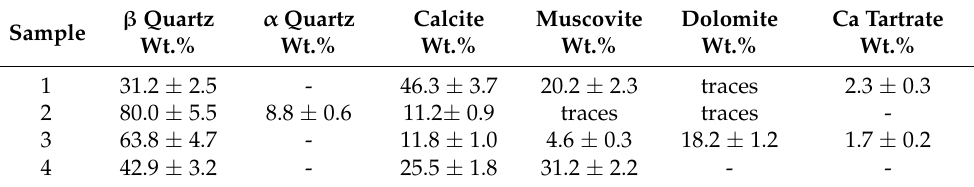
Table 1. Mineral phases found in the amphora sediments (average and standard deviation).